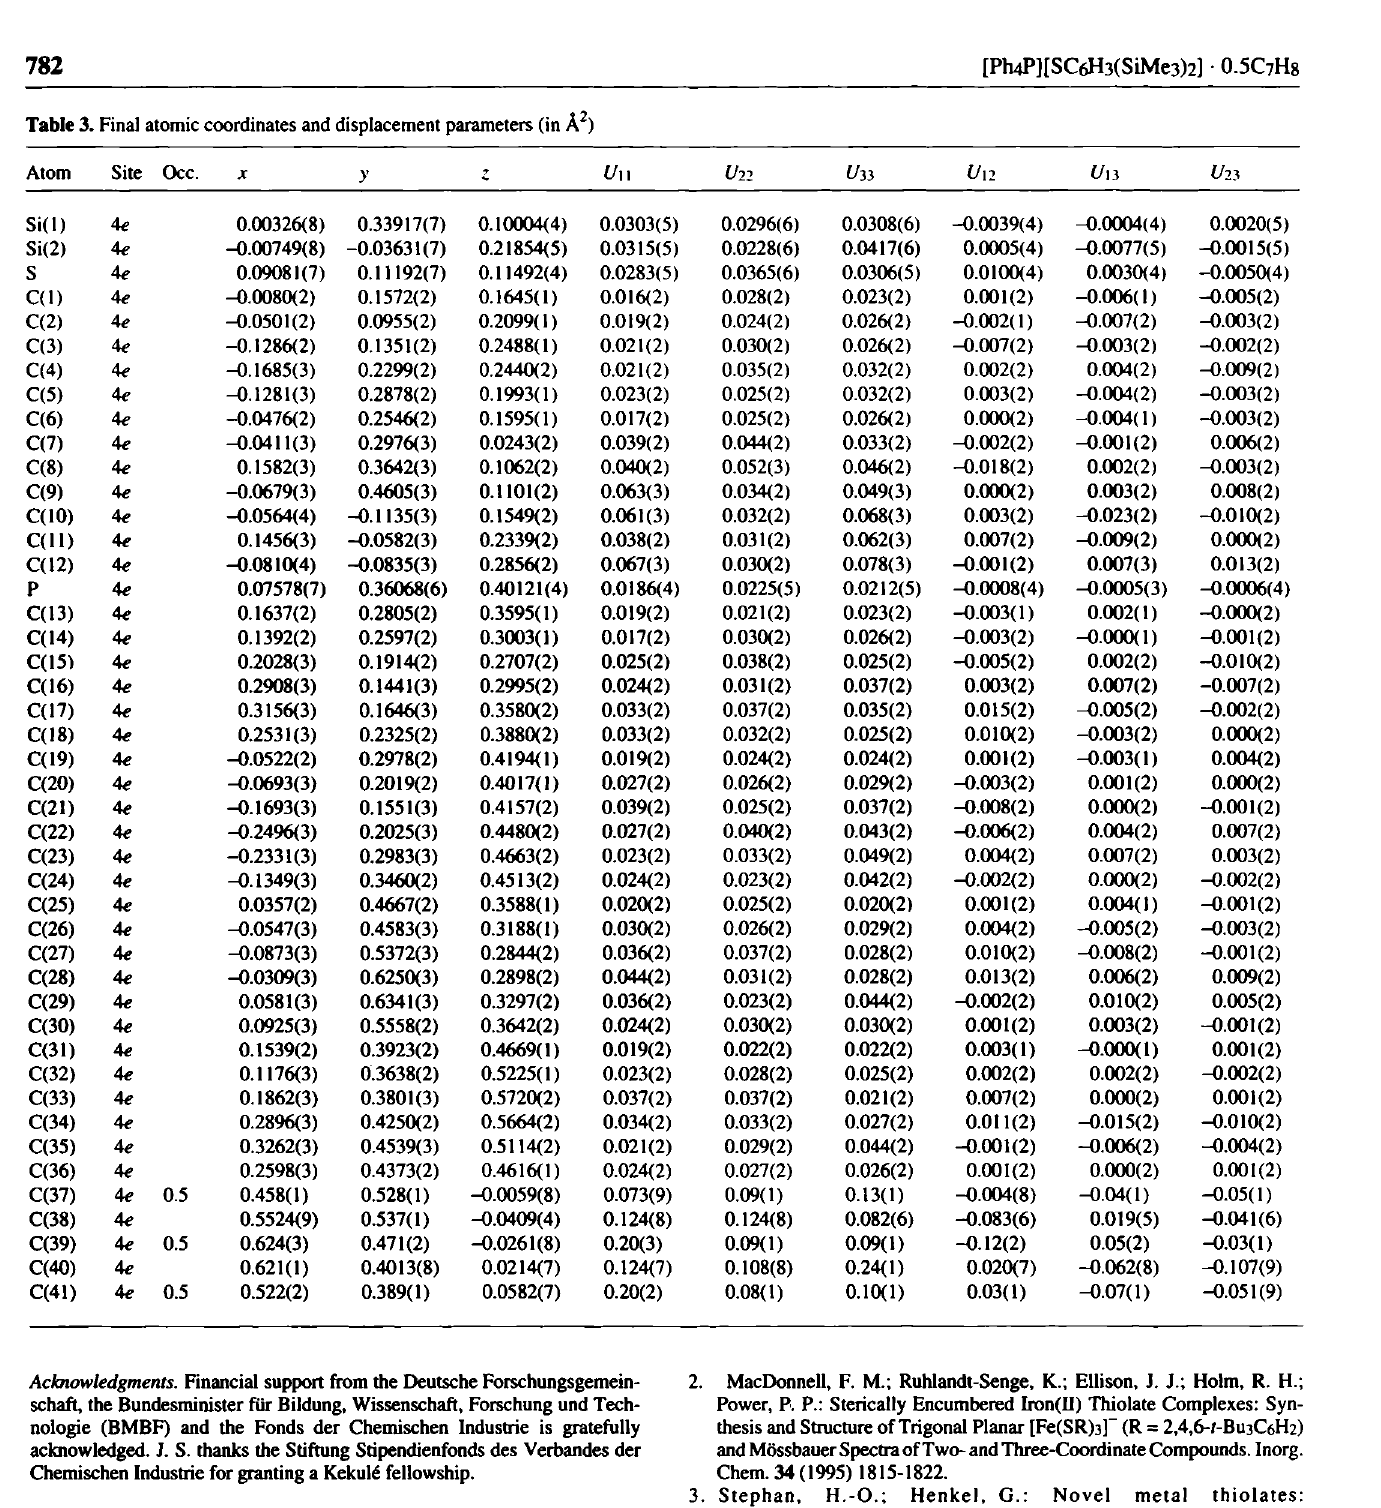
Table 3. Final atomic coordinates and displacement parameters (in Â^) Atom Site